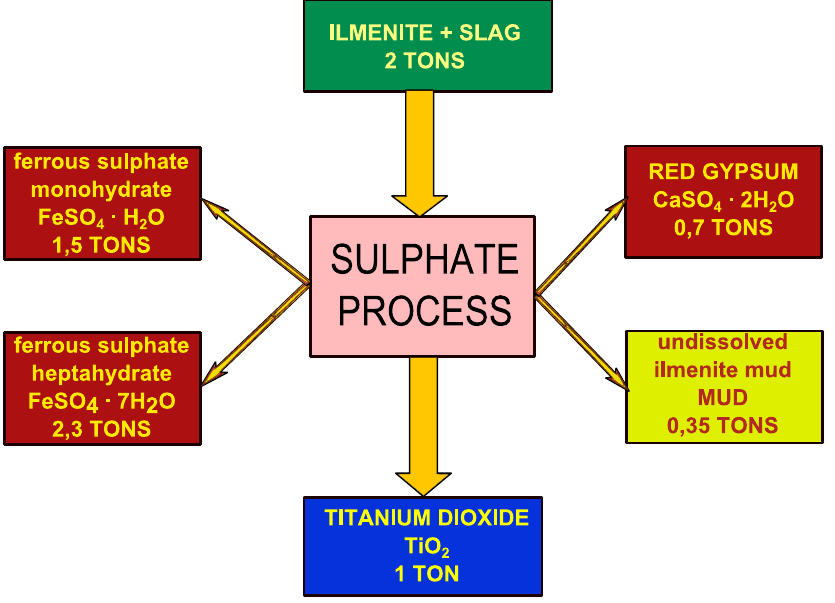
Figure 1. Wastes generated per tonne of titanium dioxide (TiO 2 ) in the sulphate method (based on data from a factory in Huelva, Spain [5]).